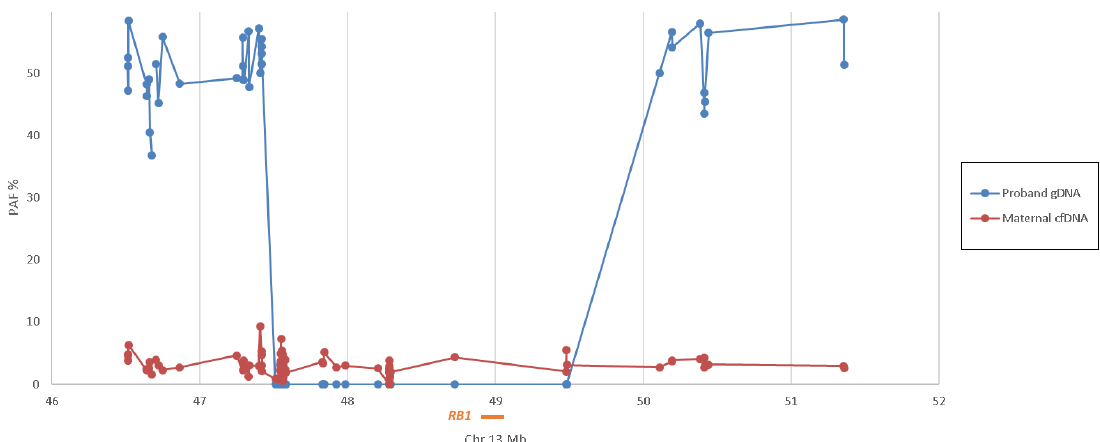
Figure 3. Graphic representation of the paternal allele frequency (PAF%) across the 5 Mb region of chromosome 13 containing RB1 (orange bar) within the previous a ff ected child (proband) gDNA (blue line) and maternal cfDNA (red line) of Family N. The a ff ected child is hemizygous for chr13:47,515,019–49,482,240. The maternal cfDNA had a calculated fetal fraction of 6% and an average of 2.83% paternal alleles across the region, indicating that the fetus is una ff ected. Analysis of the cfDNA derived from maternal plasma detected a fetal fraction of 6.25%.